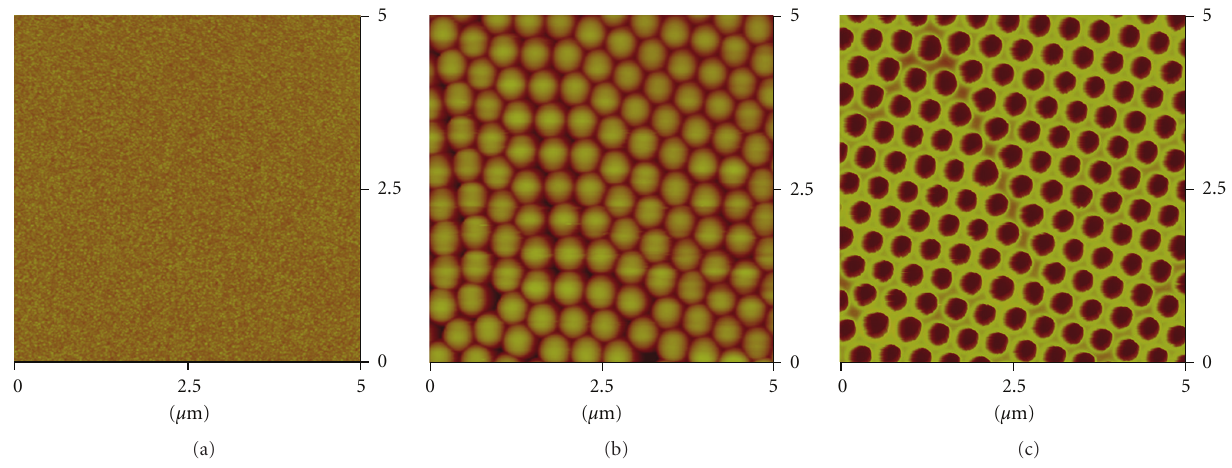
Figure 2: Tapping mode AFM images (5 µ m × 5 µ m) of (a) a bare gold electrode, (b) hexagonally packed PS spheres in a silica film-coated gold electrode, and (c) the nanowells formed after chemical removal of the PS spheres.